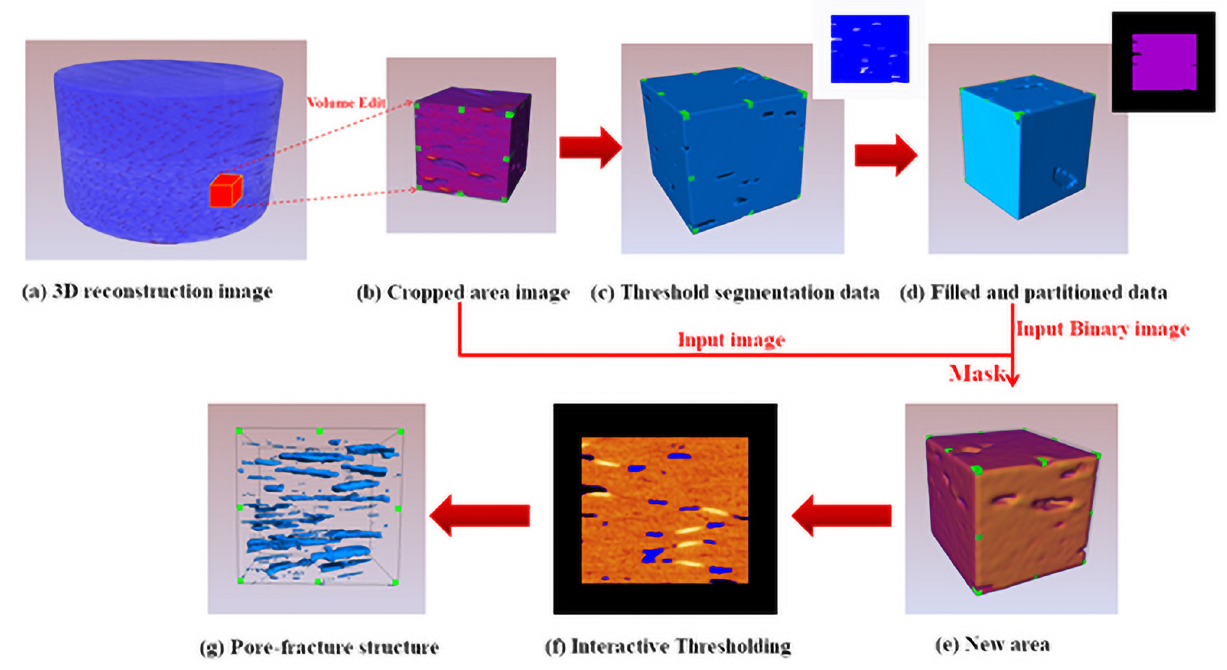
Fig 4. Image segmentation process of pore extraction in carbon fiber